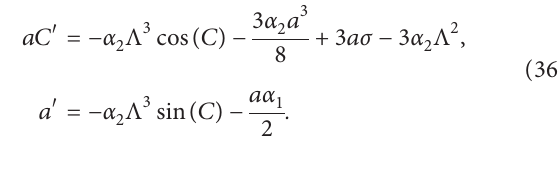
Figure 3: Frequency response for primary resonance. (a) Ω ≈ 1, α and broken lines are used for the loci of stable and unstable responses,